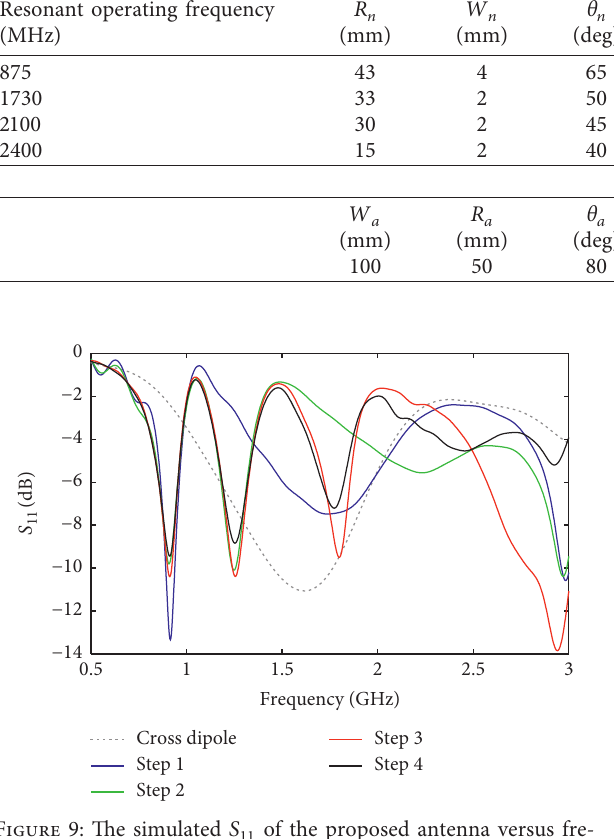
of the proposed antenna versus fre- 11